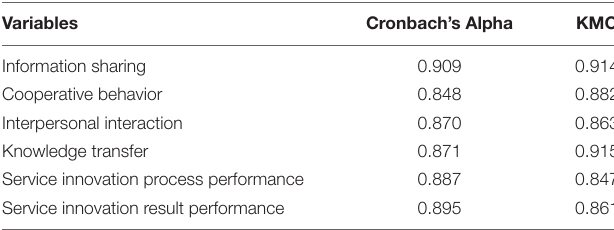
TABLE 1 | Reliability and validity analysis of variables.